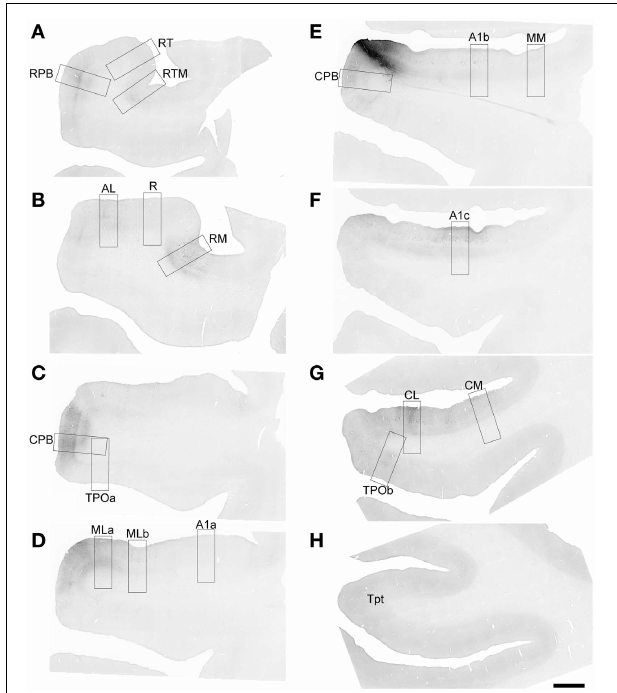
FIGURE 4 | FR labeling by the injection of ML in Case 2. Low magnification images of sections oriented from rostral (A) to caudal (H) along the STG. Black signal visible in each panel shows anterograde and retrograde transport from the FR injection in the caudal and lateral portions of ML (E) . Rectangular selections correspond to higher magnification images in Figure 5 . Scale,